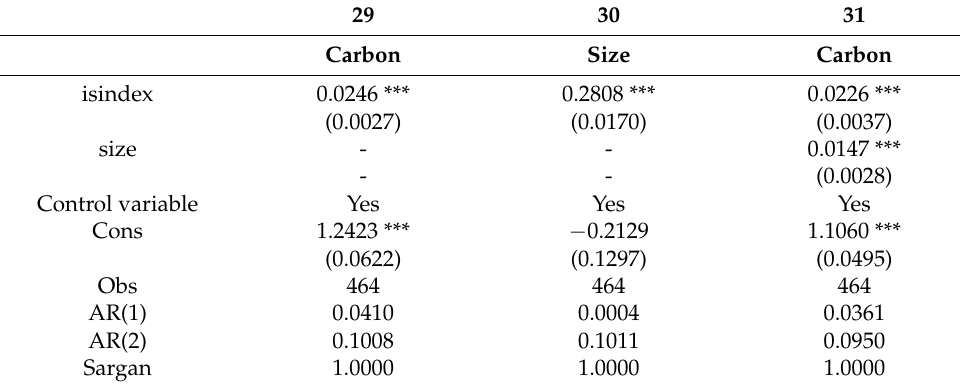
Table 8. Intermediary effect of economies of